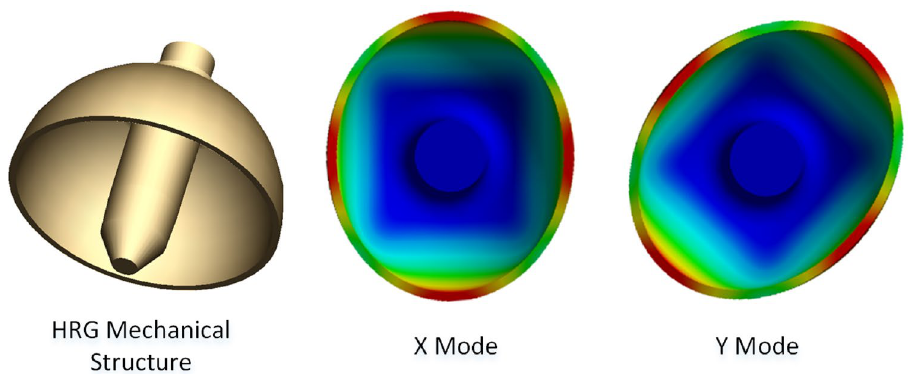
Figure 1. Degenerated gyroscopic modes of the